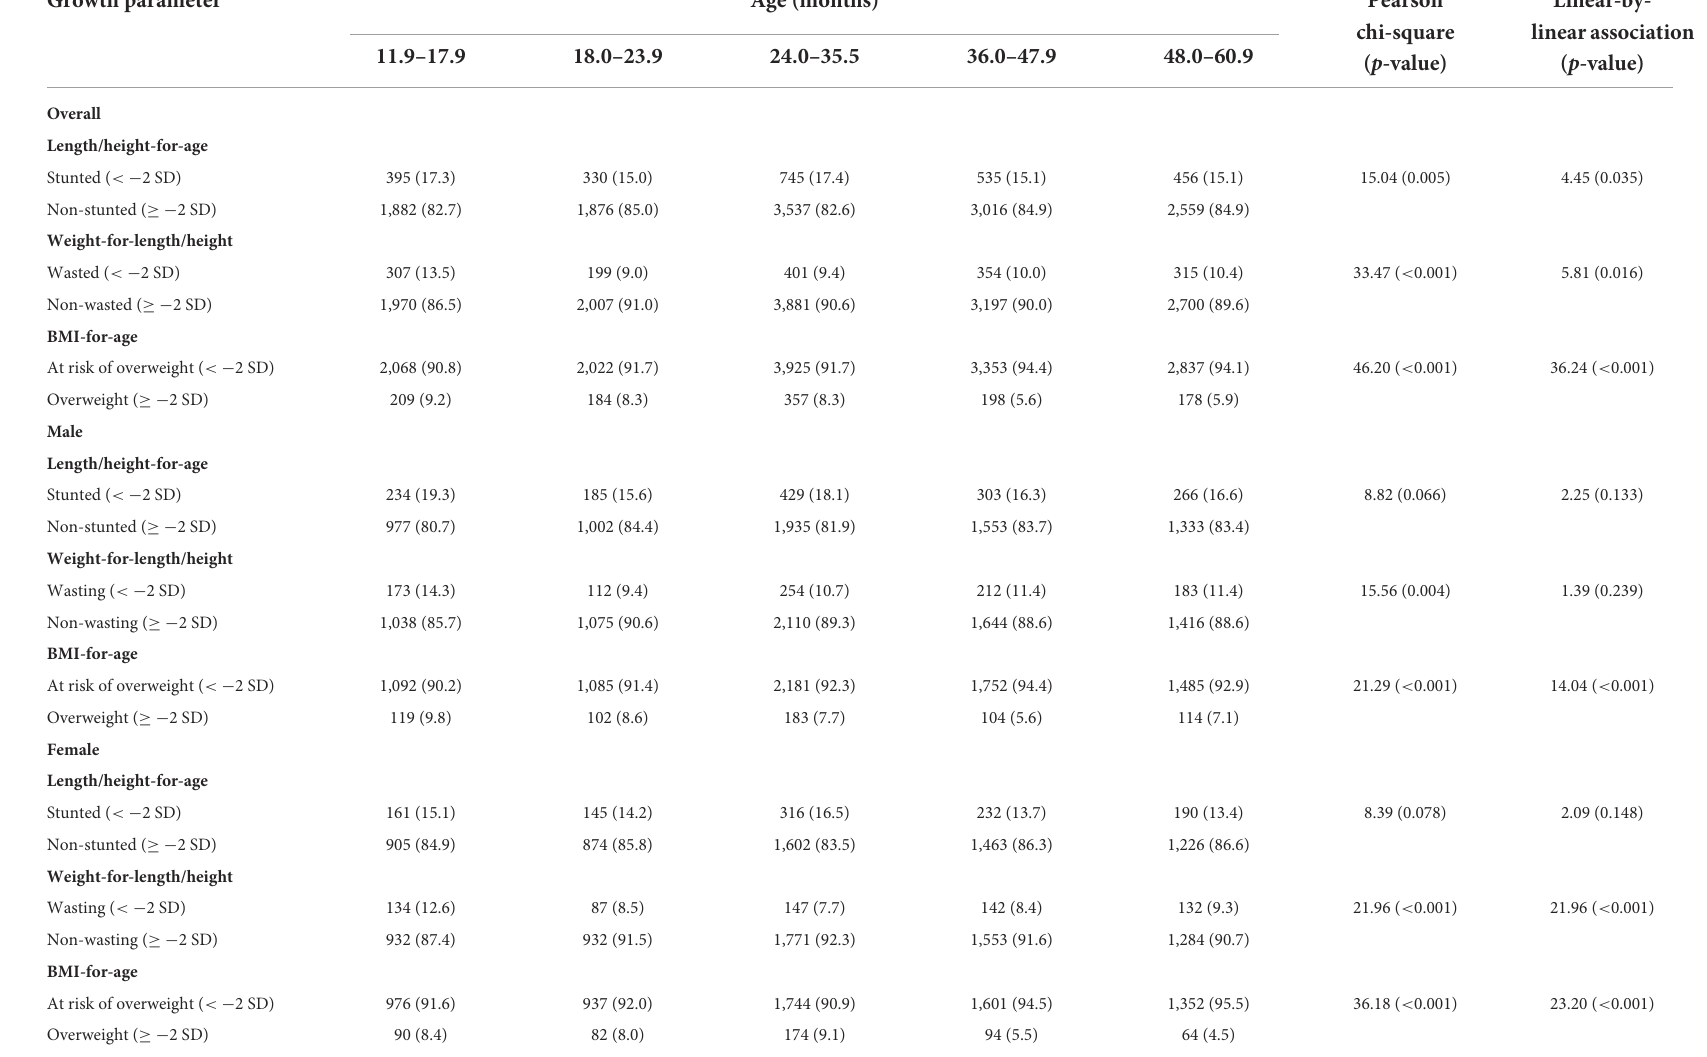
TABLE 2 Growth status of 15,331 children by age group and gender. Growth